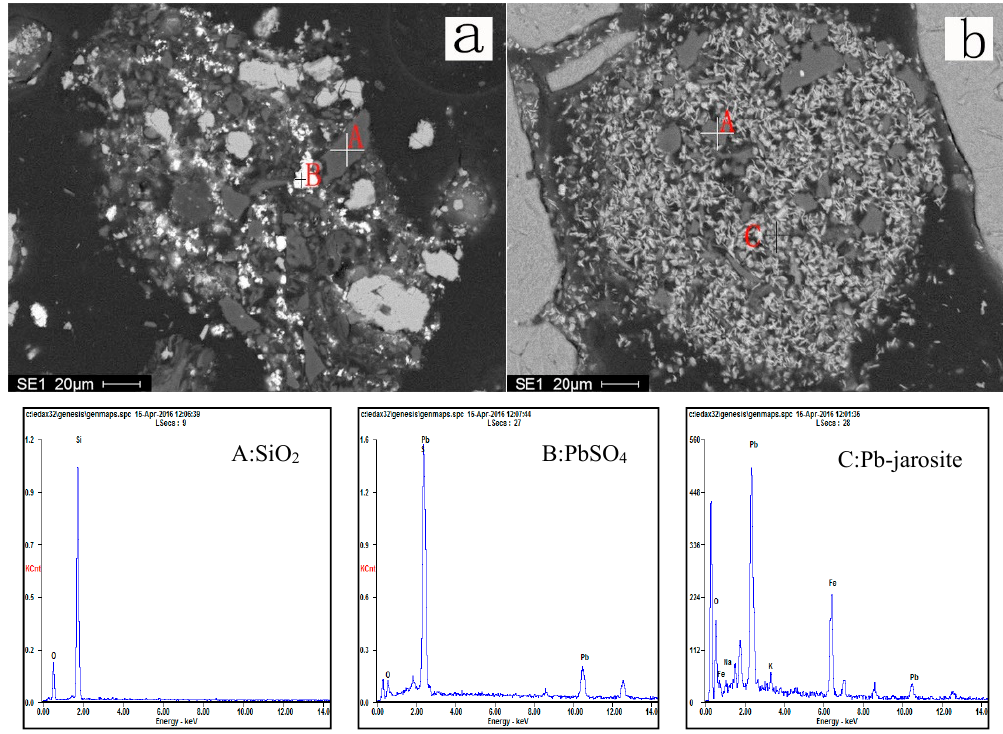
Figure 22. SEM images and EDS spectrum of leach residues ( a ): leaching time 0.5 h; ( b ): leaching time 2.5 h .